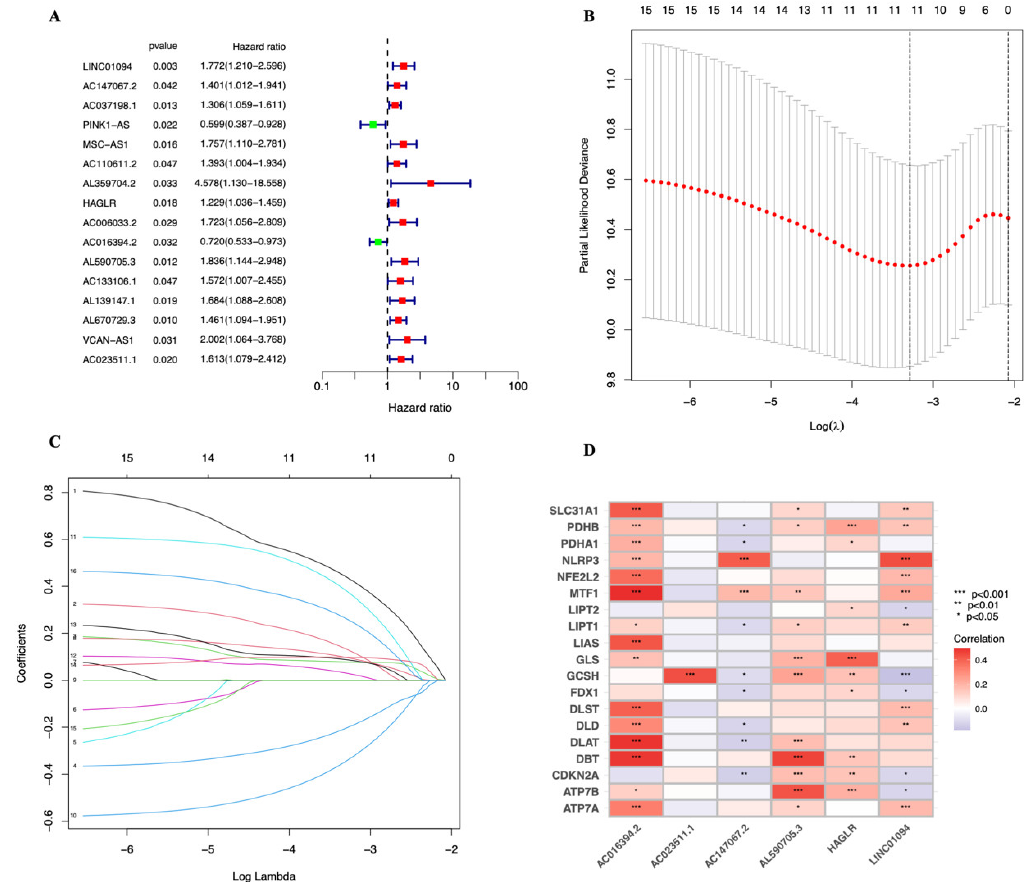
Figure 2. Identification of cuproptosis-associated lncRNA signature in STAD. ( A ) Univariate Cox regression analysis for identifying the prognostic cuproptosis-related lncRNAs. ( B , C ) Lasso–Cox regression analysis was performed to construct prognostic prediction models. Each curve in Figure 2C represents the change trajectory of each coefficient of the independent variable (representing a LncRNA in this study). The ordinate is the value of the coefficient, the lower abscissa is log (λ), and the upper abscissa represents the number of non-zero coefficients in the model at this time. ( D ) Correlation of lncRNAs with cuproptosis-related genes in risk models.